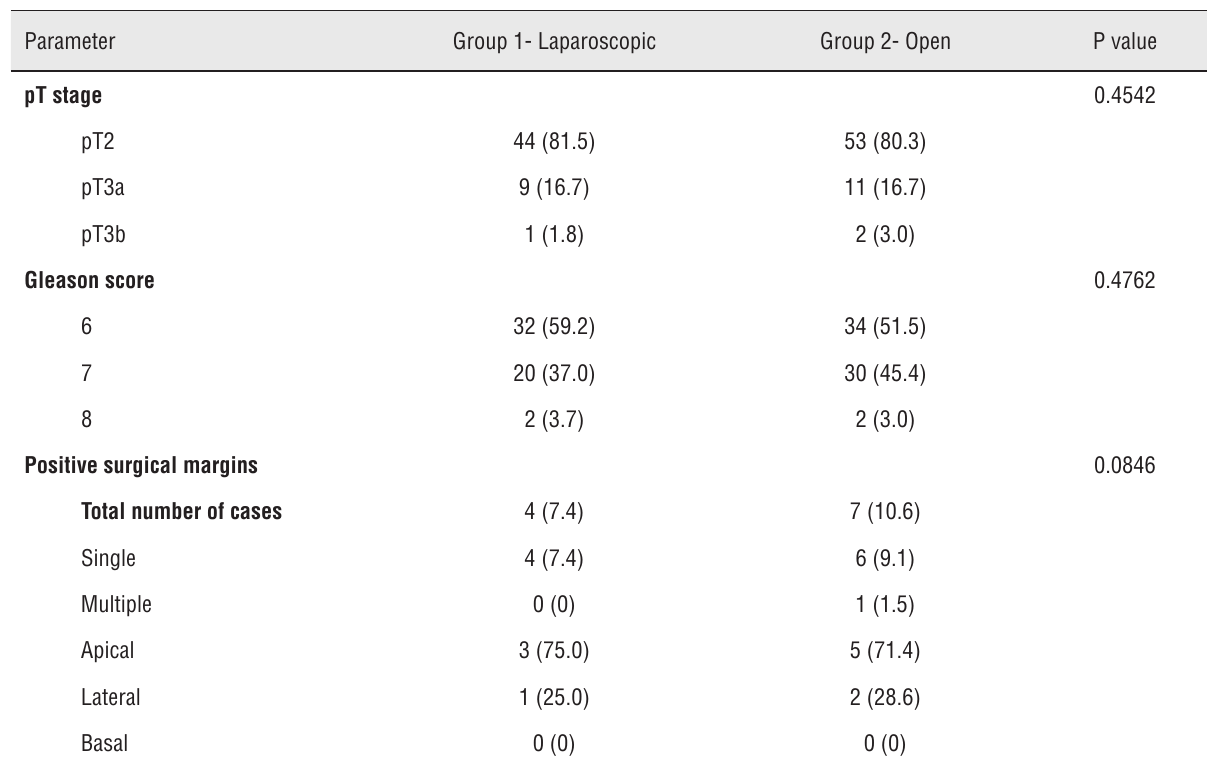
Table 3 - Comparison of pathological outcomes between laparoscopic and open procedures. Results are presented as mean ± sD (mean) and range or number (%) of